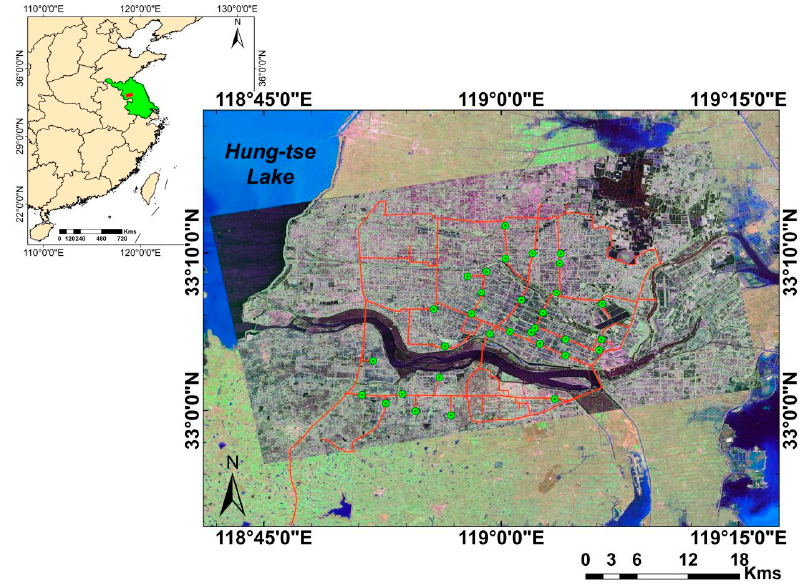
Figure 1. Study area in the RGB color image of polarimetric Radarsat-2 data on 27 June 2012 (R = HH, G = HV, B = VV). The paths of the field investigation (red lines) and the location of rice sample fields (green dots) are both displayed. The Landsat-8 Operational Land Imager (OLI) true color image is used as a backdrop.